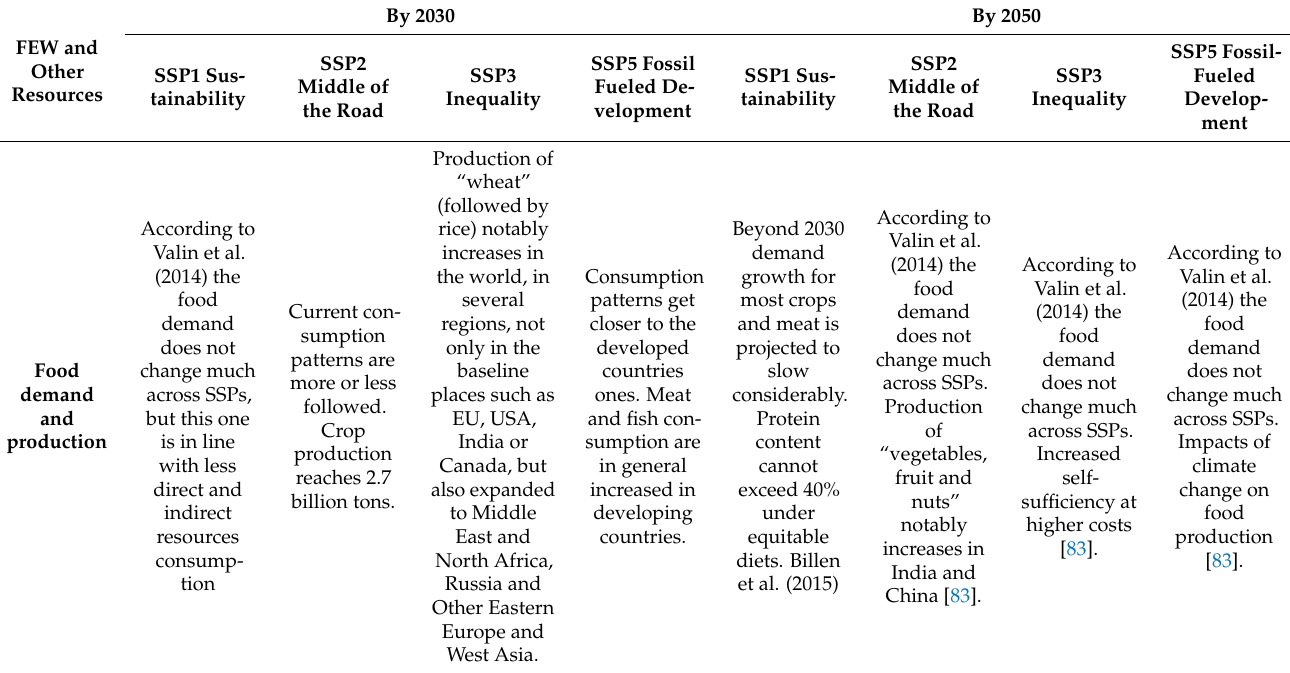
Table 2. Summary of results by each scenario, in terms of